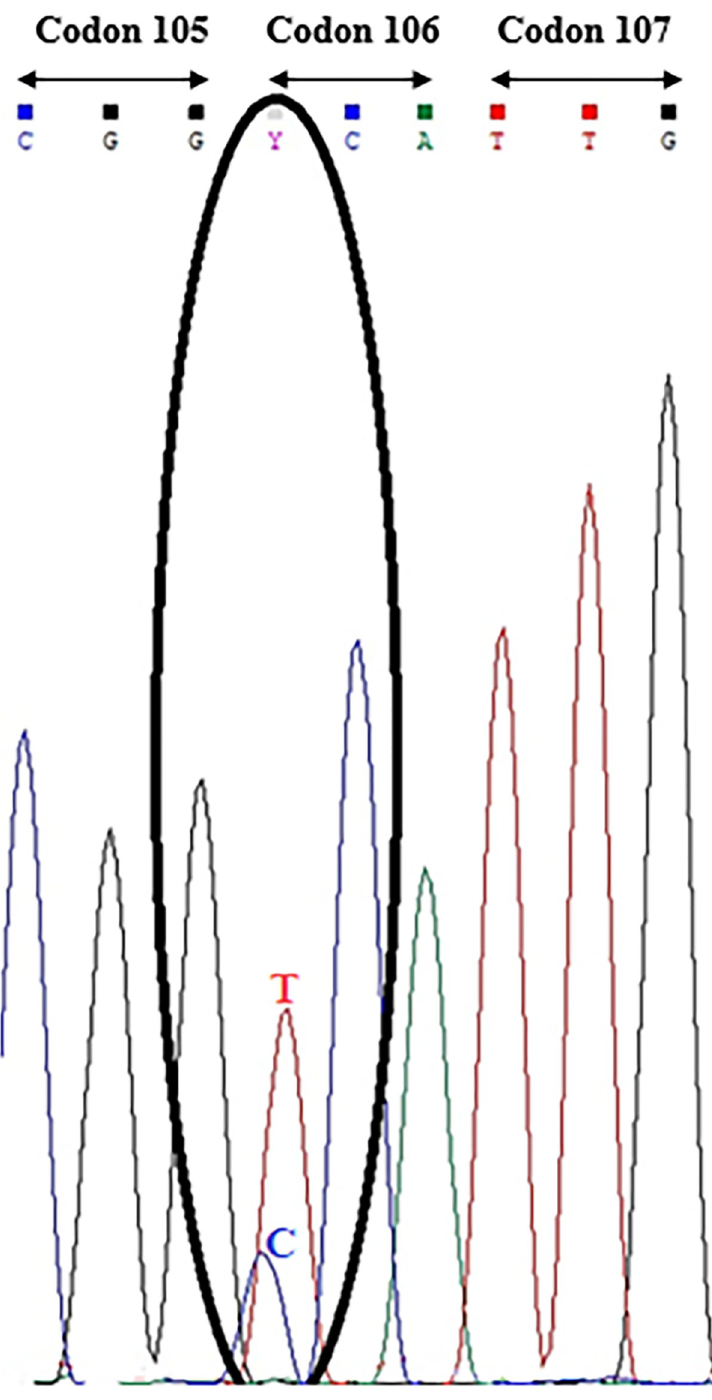
Fig 2. Sequence chromatogram showing codons 105 to 107 of a 300 bp PCR amplified section of the EPSPS gene of a perennial ryegrass individual from glyphosate resistant population O. As both alleles in the individual were sequenced simultaneously the chromatogram revealed a heterozygous state at the first base of codon 106 (circled) identified as a pyrimidine (Y) comprising the wild type glyphosate sensitive C nucleotide overlapping with the glyphosate resistant T mutation at this position. This non-synonymous mutation indicated one allele in this glyphosate resistant individual had a Pro (CCA) to Ser (TCA) substitution at codon 106.